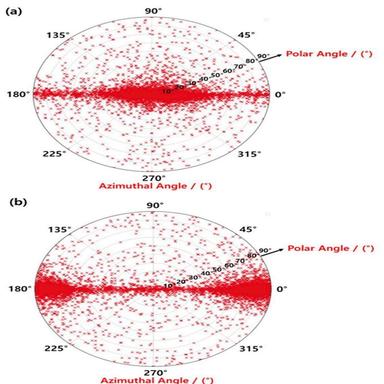
Mapping images of the fiber orientation distribution for the (a) longitudinal and (b) transverse specimens.